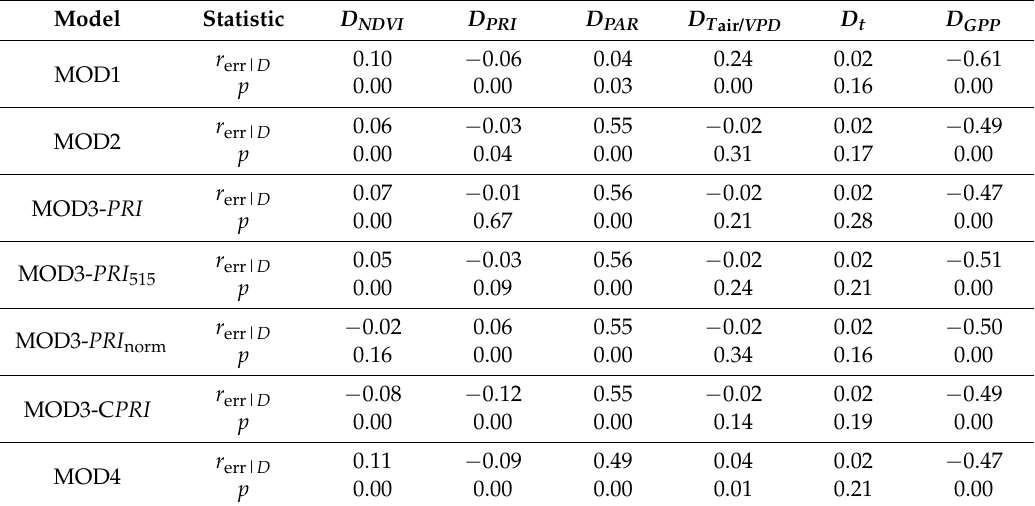
Table 6. Partial correlation coefficients and significance between GPP hh prediction errors and the Euclidean distance between each half-hourly input variable the day of the flight campaigns and the surrounding days.